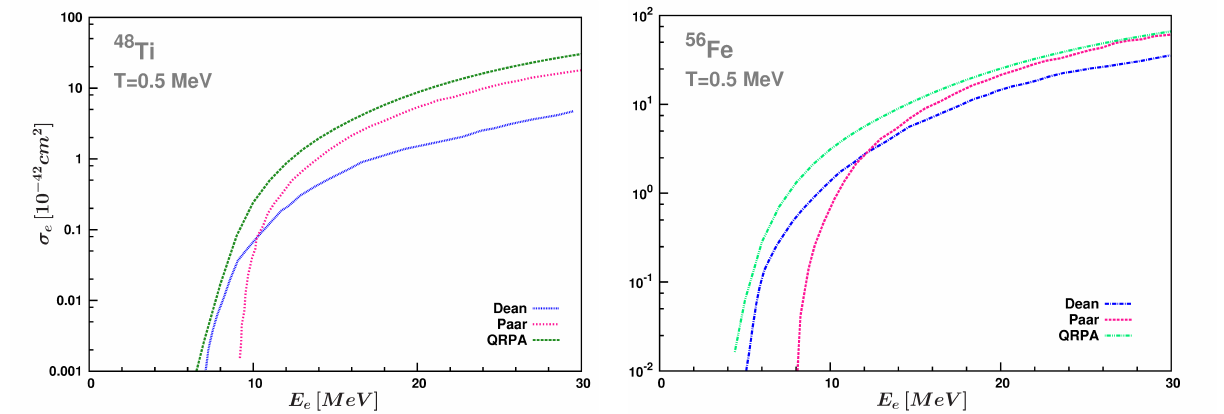
Figure 3. Comparison of our GT contribution in total electron-capture rates for 48 Ti and 56 Fe with those of other model calculations: (i) Paar et al. [12] and (ii) Dean et al.